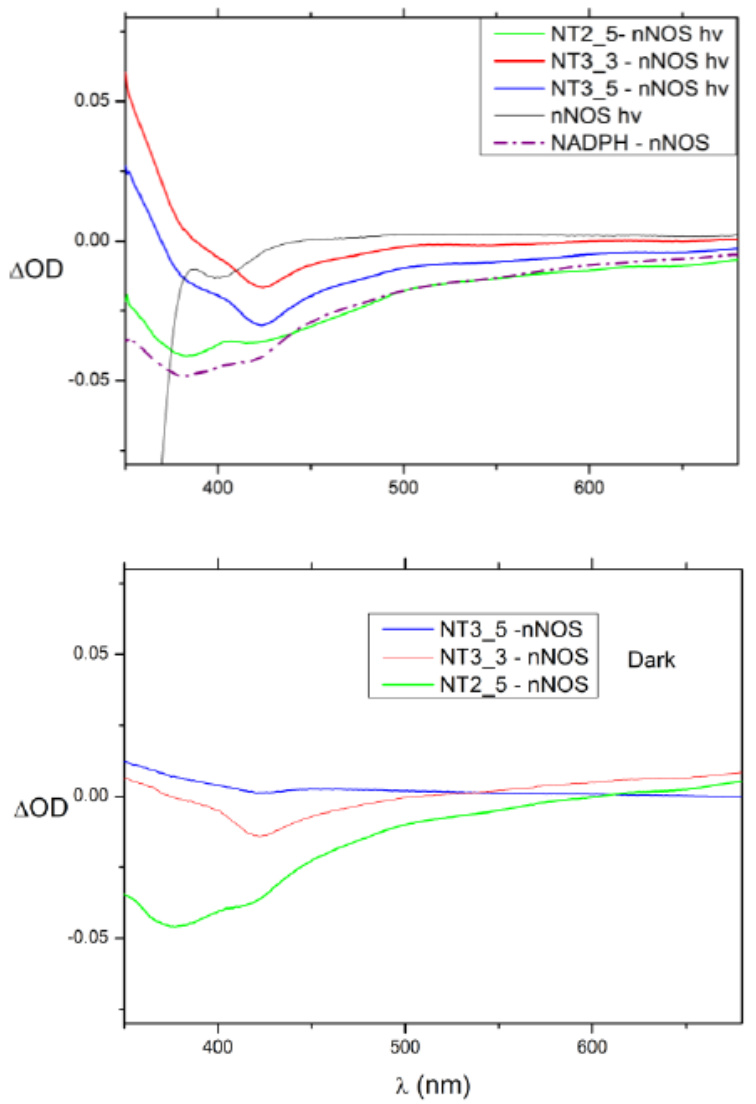
Figure A2. Upper panel: Spectral changes attesting to flavin reduction (minima around (380, 420, 460 nm) upon light irradiation at 365 nm: 2 µM bound NT2_5 and NT3_5 to 5 µM nNOS or NT-free nNOS as compared with absorption changes upon flavin reduction with NADPH; some spectral changes observed in the presence of NT3_3 or NT2_5 were also present without light irradiation; bottom panel shows the same conditions as above with no light. Spectral changes are observed with NT2_5 without light, suggesting it can reduce FAD in the ground state. Dark flavin reduction that is similar to light-induced reduction is also observed using NT3_3. This means that NT3_3 is not a light trigger and that its ground state redox potential is more reducing than NT3_5 is. Only NT3_5 reduced the flavin upon light irradiation. 100 mM NOHA, 100mM Ca 2+ , 1 µg recombinant calmodulin, 20 mM Tris Buffer at pH = 7.8, 100 mM NaCl; representative data out of 2 experiments.